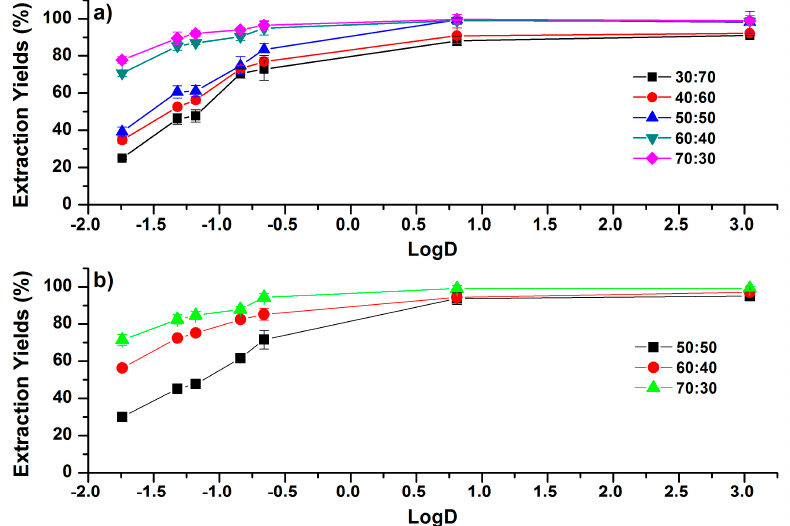
Figure 6. Correlations between EYs and the LogD (pH 7.4) values of phenolic compounds under different concentration of ACN in the ACN–H 2 O mixture (ACN:H 2 O, v / v ) for ( a ) DCM and ( b ) chloroform. The addition volumes of DCM and chloroform were 25% and 15% of the initial volume of ACN in the ACN–H 2 O mixture, respectively. Error bars present the standard deviation ( n = 3).